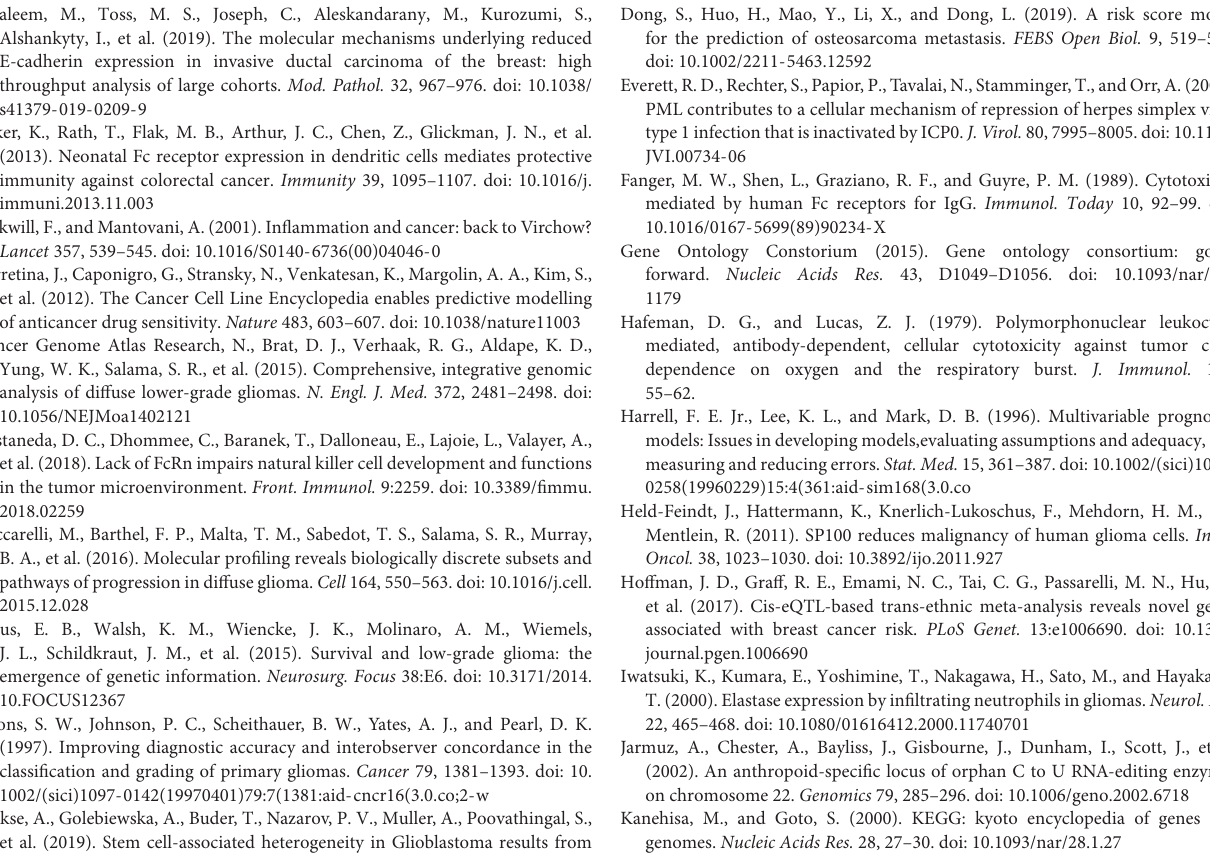
Red dots, and green dots represent up-regulated genes, and down-regulated genes, respectively. FIGURE S3 | Weighted gene correlation network analysis for building stemness-index associated preserved Modules. (A) Determination of soft threshold for adjacency matrix, and plots of mean connectivity versus soft threshold. (B) Clustering results of WGCNA modules. The horizontal axis indicates modules with different colors. FIGURE S4 | Analysis of key genes in the module brown. (A) The heatmap showing that the differentially expressed levels of the key genes between the normal control tissue and tumor tissue. (B) The heatmap of the correlation analysis among key genes. FIGURE S5 | (A) Kaplan-Meier survival analysis of mRNAsi. (B) Kaplan-Meier survival analysis of corrected mRNAsi. Additionally, the table indicating the number at risk for each group at corresponding time points. FIGURE S6 | Association between risk score and clinical-pathological parameters. Association between risk score and age, gender, grade, radiotherapy, chemotherapy, and IDH mutation status of primary LGG patients in TCGA cohort (A) , in CGGA cohort (B) . FIGURE S7 | The mRNA expression level of ADAP2 (A) , ALOX5AP (B) , APOBEC3C (C) , FCGRT (D) , GNG5 (E) , LRRC25 (F) , and SP100 (G) in different types of human cancers. FIGURE S8 | The protein expression level of immunohistochemistry (IHC) images collected from the Human Protein Atlas database of the risk genes between glioma tissue and normal control (ADAP2 was not